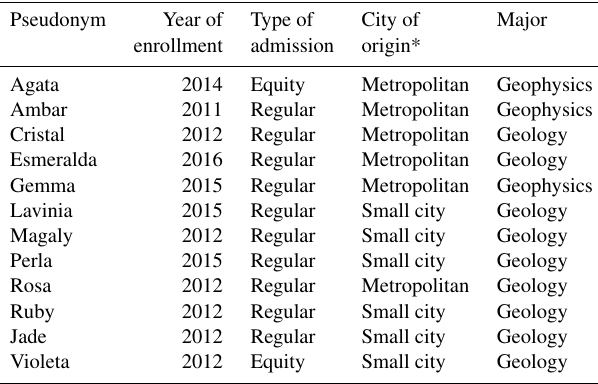
Table 2. Geoscience female undergraduate